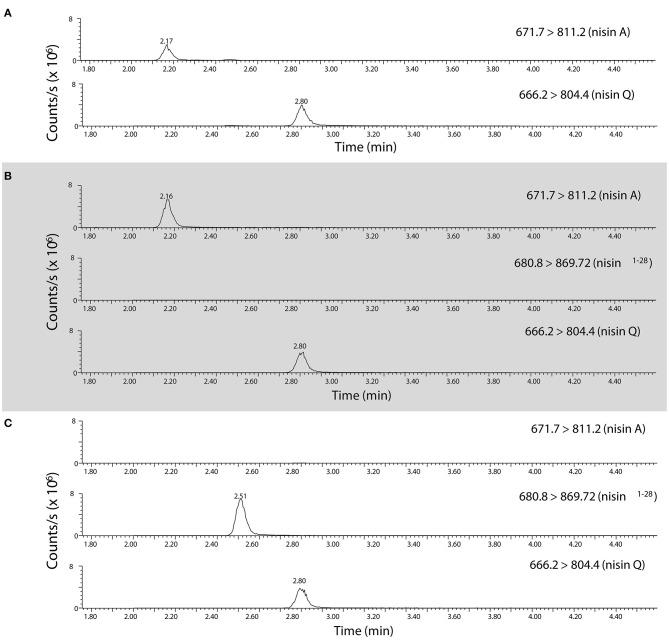
Identification of nisin A, nisin Q, and nisin1−28 in CFS using high resolution mass spectrometry. HPLC-MS/MS MRM transitions of quantification ions for nisin A [the [M+5H]5+ ion from m/z 671.7 to 811.2], nisin Q [the [M+5H]5+ ion of nisin Q from m/z 666.2 to 804.4,] and nisin1−28 [the [M+4H]4+ ion from m/z 680.55 to 869.7] as detected in (A) a control mix of nisin A and nisin Q, (B) CFS collected from CHCC 11454 (nisA+, nsr-) and (C), CFS collected from CH-1 (nsr–, nsr+). Note that the parent isolation window of the [M+4H]4+ ion of nisin1−28 (m/z 680.55) was moved m/z 0.25 as the A+1 isotopomer was the most abundant, creating the MRM transition 680.8 → 869.7.